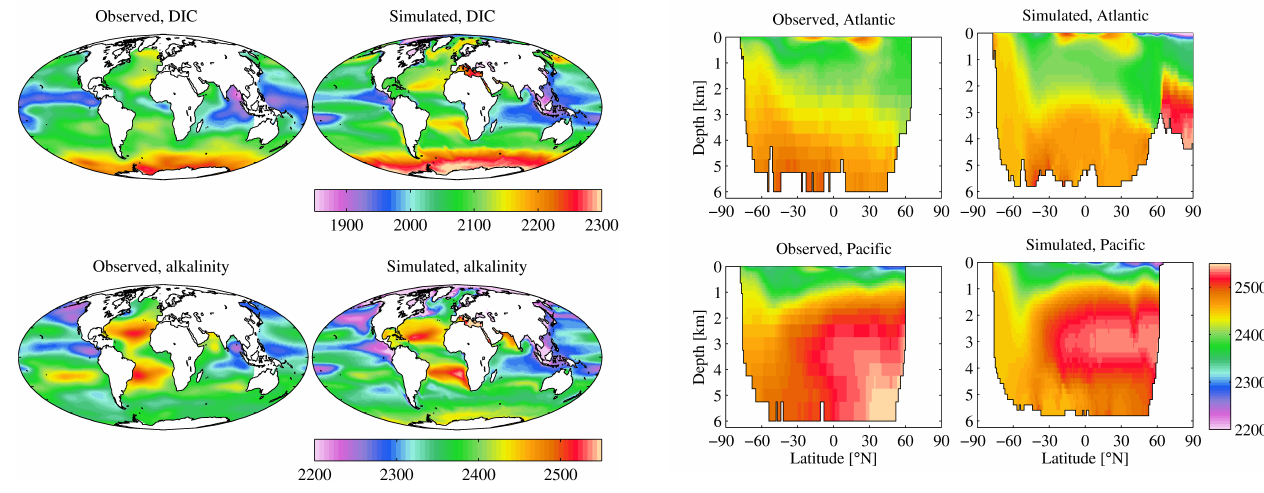
Fig. 16. Observational (GLODAP; left) and simulated (right) sur- face dissolved inorganic carbon (top; mmolCm − 3 ) and surface al- kalinity (bottom; meqm − 3 ).